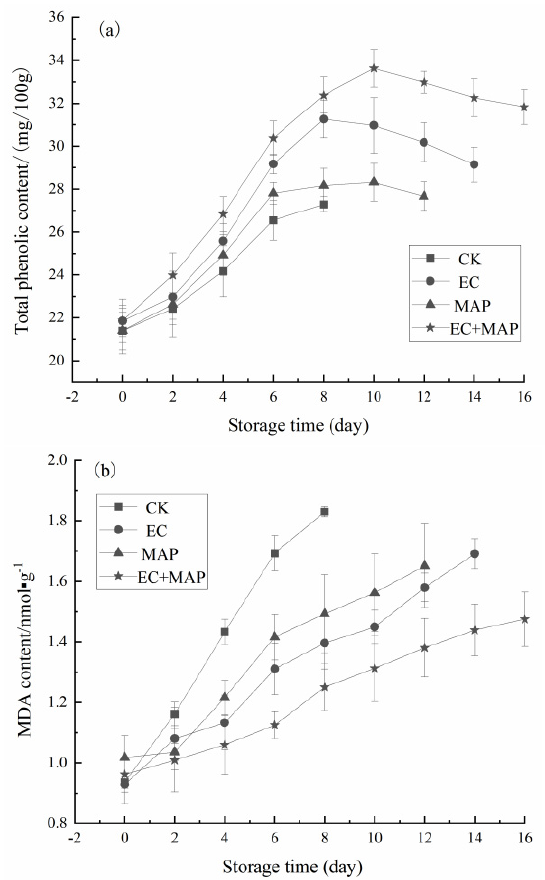
Figure 4. Effect of different treatments on total phenols ( a ) and MDA content ( b ) of fresh-cut Figure 4. E ff ect of di ff erent treatments on total phenols ( a ) and MDA content ( b ) of fresh-cut pine- pineapples during apples during storage.